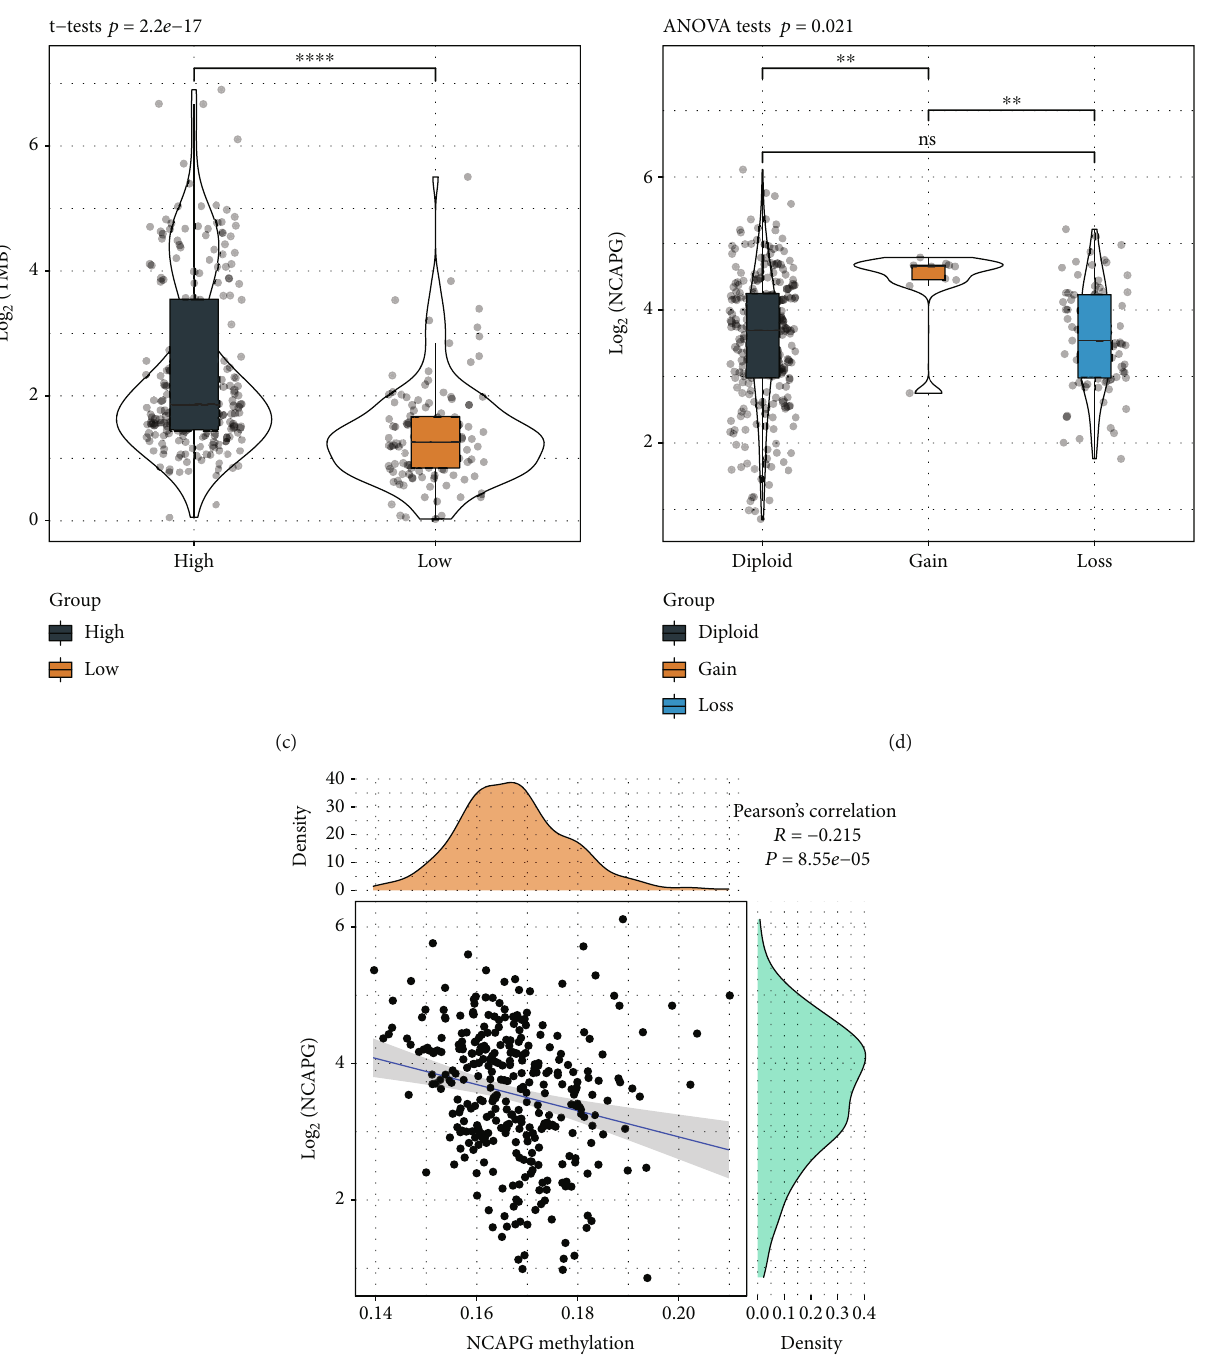
Figure 3: Analysis of SNVs, CNVs, and methylation pro fi les in STAD. (a) KM curve with 0 as the cuto ff after expression z -score transformation; (b) mutational distribution for the top 10 genes with the highest mutation frequency in NCAPG expression subgroups; (c) comparison of TMB distribution between NCAPG expression subgroups; (d) NCAPG ampli fi cation subgroups based on expression di ff erences; (e) correlation analysis for NCAPG expression and methylation status ( ∗ , P < 0 : 05 ; ∗∗ , P < 0 : 01 ; ∗∗∗ , P < 0 : 001 ; ∗∗∗∗ , P < 0 : 0001 ; ns, P > 0 : 05